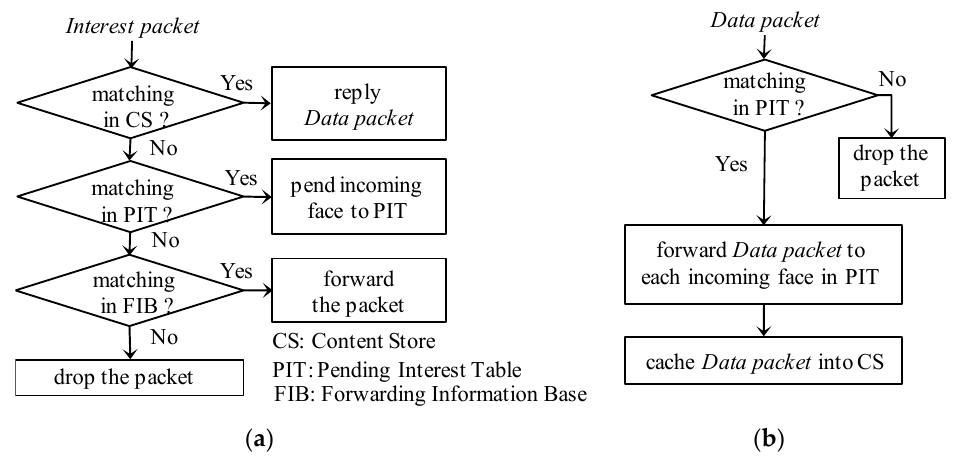
Figure 2. Forwarding processes in NDN router for: ( a ) interest packet and ( b ) data packet .